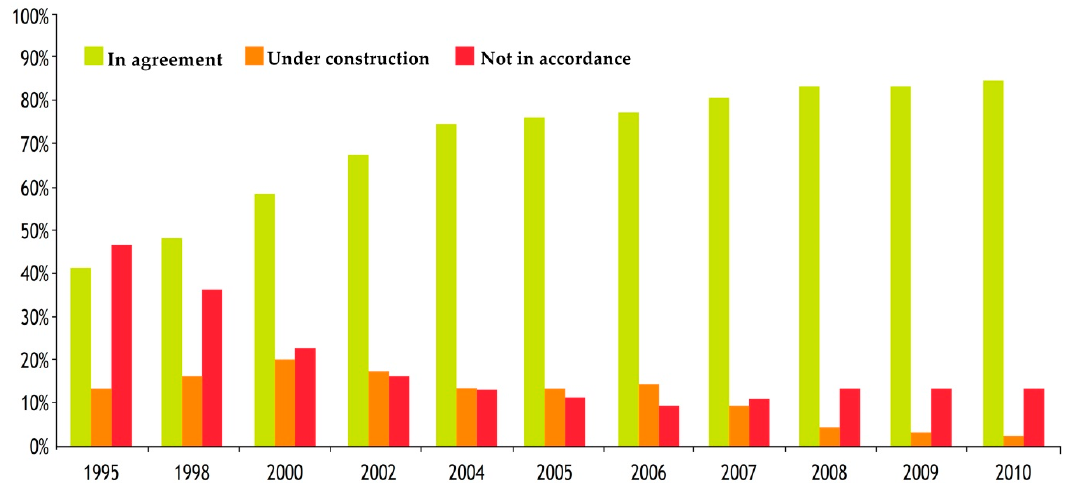
Figure 2. Compliance degree of Spain with the Directive 91 / 271 / EEC (1995–2010 period). Source: own elaboration based on [24,57].